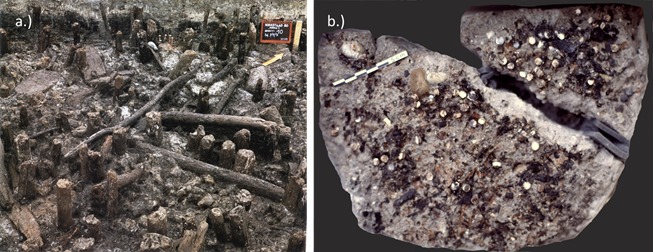
Excavations at Hornstaad D-Hörnle site (a) and the discovery of the double-buttons (b).